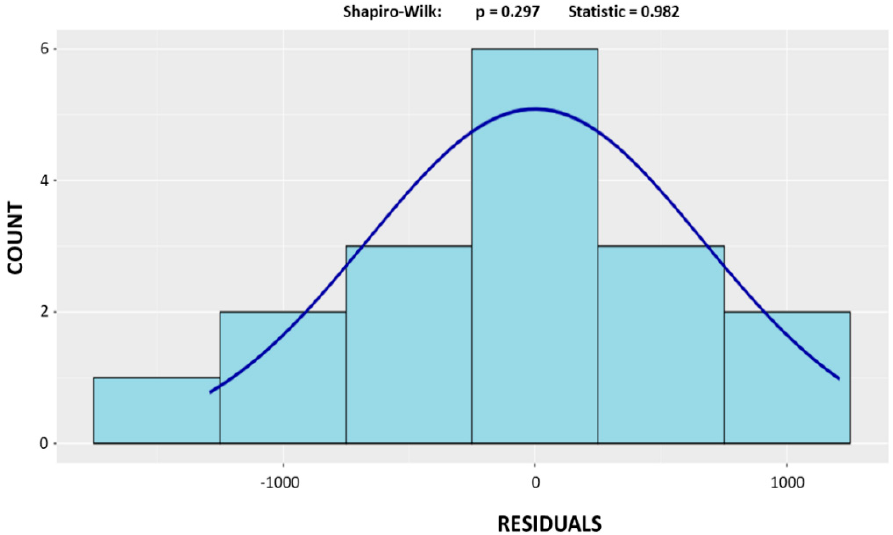
Figure A1. Histogram of the residuals of the stepwise model to assess the normality assumption.